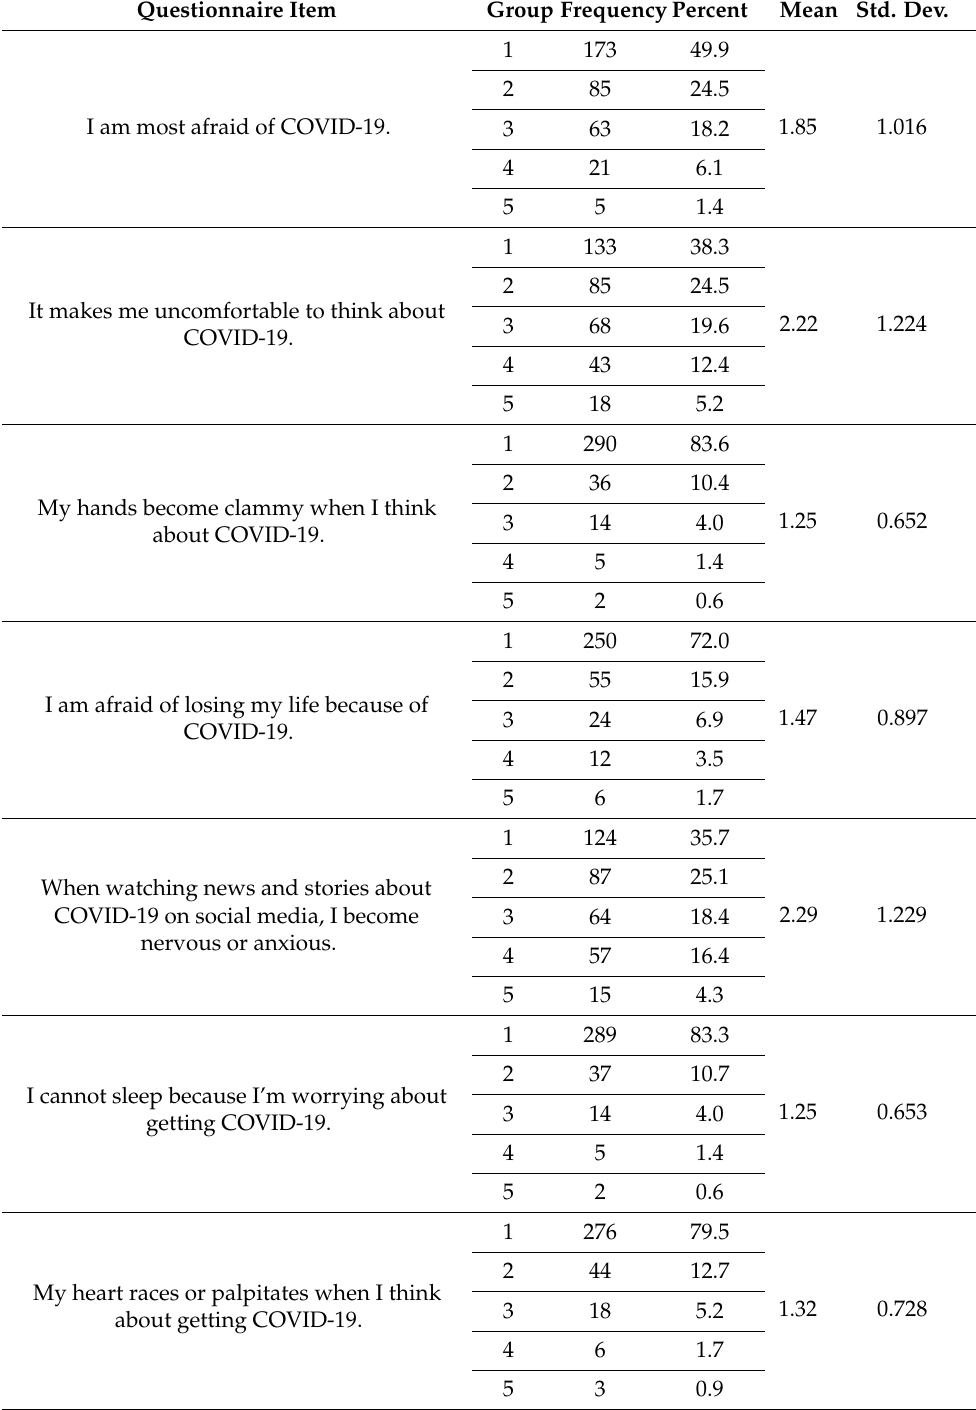
Table 2. Distribution of answers to individual questions of The COVID-19 Fear Scale. Questionnaire